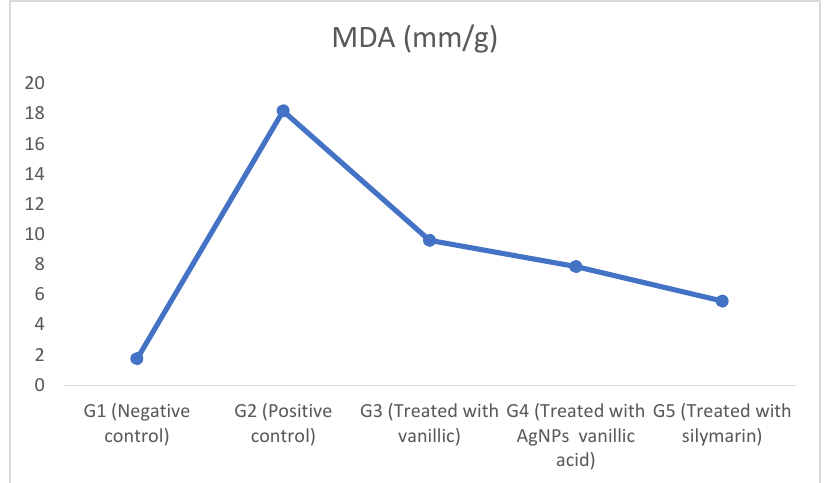
Figure 6. The effects of vanillic acid-loaded silver nanoparticles on malondialdehyde (MDA) in liver tissues of CCl 4 liver toxicity-induced rats.